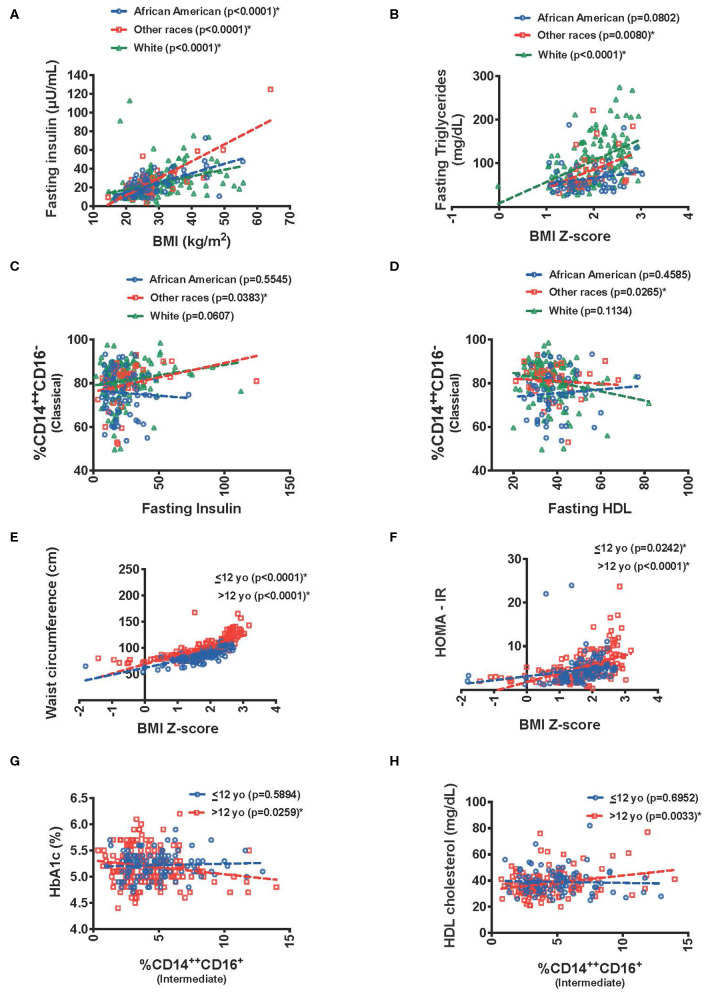
Graphical display of effect of race/ethnicity and age interactions between predictor and metabolic outcome variables. Relationship between (A) fasting insulin and BMI, (B) fasting triglycerides and BMI Z-score, (C) classical monocytes and fasting insulin, (D) classical monocytes and fasting HD with race/ethnicity interactions. Relationship between (E) waist circumference with BMI Z-score, (F) HOMA-IR with BMI Z-score, (G) HbA1C(%) with intermediate monocytes, and (H) fasting HDL with intermediate monocytes with age interactions. *The “Other race” category includes: All participants who reported Asian and Hispanic race, and who reported more than one race.